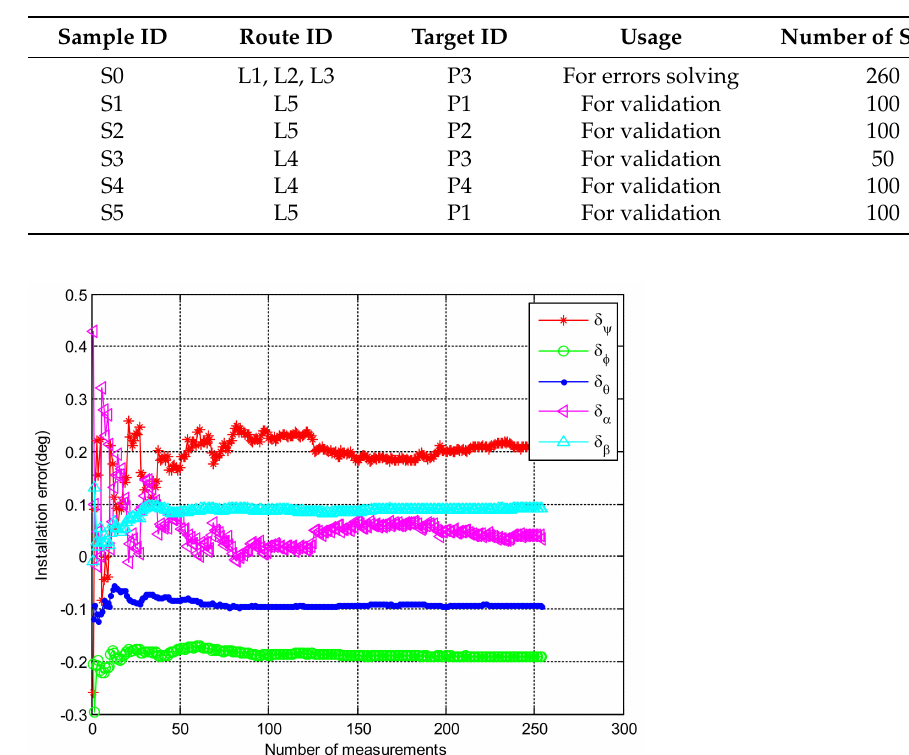
Figure 10. Target positioning flight experiment: ( a ) The plane flied on the left side of the target; ( b ) The plane flew on the right side of the target. Table 5. Samples of flight routes and relevant target points.